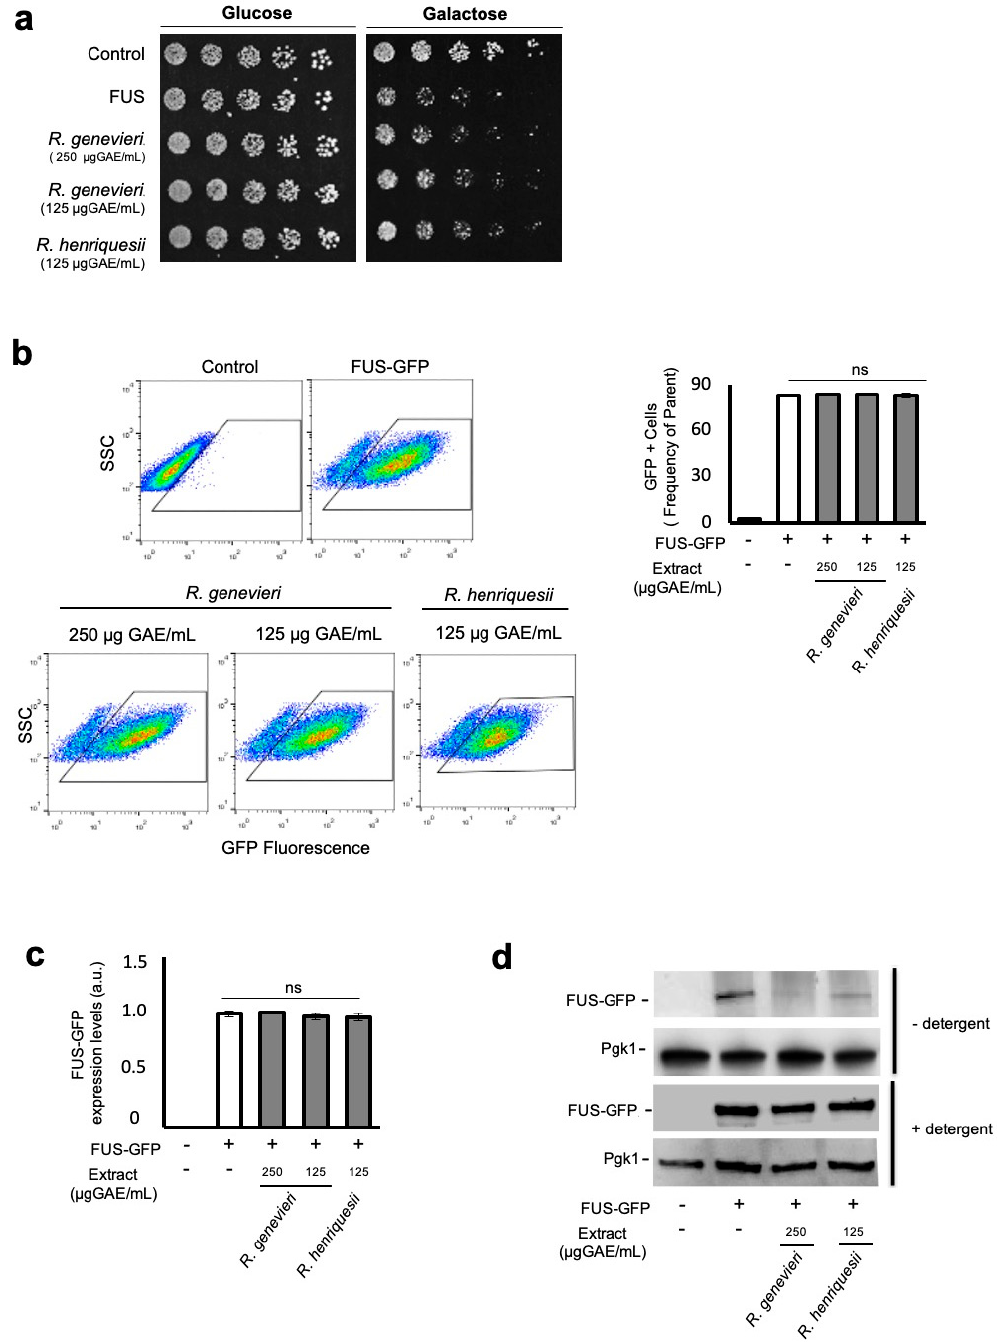
Figure 2. Bioactivity towards Amyotrophic lateral sclerosis is associated with the reduction of soluble FUS levels by R. genevieri . W303-1A recombinant cells expressing FUS were pre-grown in synthetic complete ra ffi nose medium, and cells encoding the empty vector were used as the control. ( a ) The viability of cells exposed or not to the indicated concentrations of phenolic compound-enriched extracts was assessed by phenotypic growth assays on synthetic complete glucose and synthetic complete galactose media. ( b ) FUS expression evaluated by side scatter (SSC) versus FUS–GFP fluorescence, assessed by flow cytometry (left panel). The percentage of FUS–GFP-positive cells is shown (right panel). ( c ) FUS–GFP expression levels as evaluated by qRT-PCR. ( d ) FUS–GFP protein levels upon extraction in the presence or absence of detergent as evaluated by immunoblotting. Representative images are shown, and the values represent the mean ± SEM of at least three biological replicates.